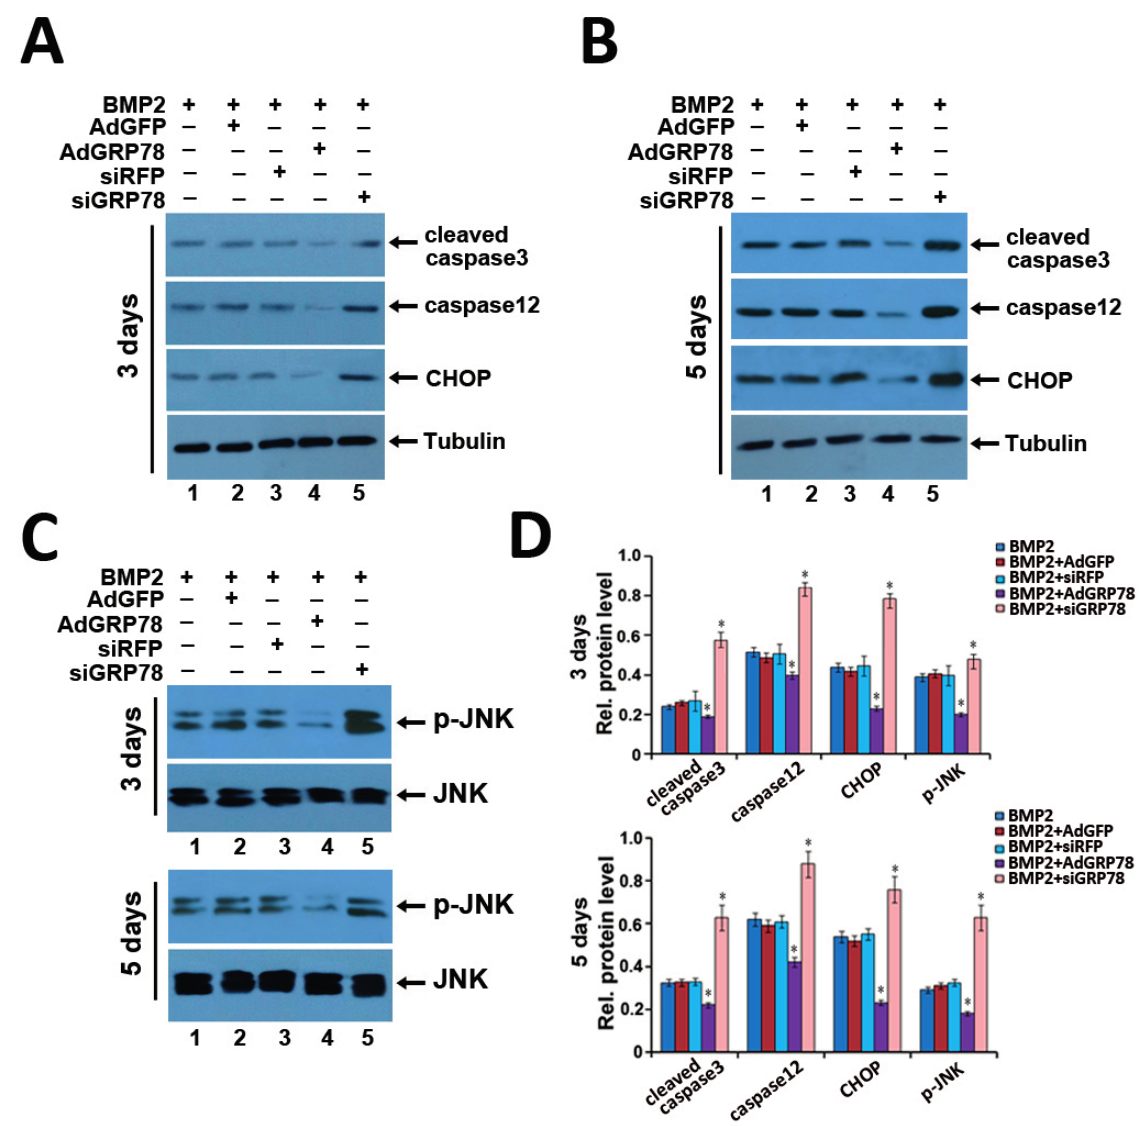
Figure 6. The effects of GRP78 on the expression of ER stress-associated molecules in BMP2-induced C3H10T1/2 cells for three and five days. ( A – C ) Expression of cleaved caspase3, CHOP, caspase12, tubulin, JNK and p-JNK in the course of chondrogenesis in a micromass culture of BMP2-induced C3H10T1/2 cells for three and five days. Whole cell lysates were prepared from C3H10T1/2 cells were treated with 300 ng/mL BMP2 for three and five days. The lysates were resolved by SDS-PAGE and then immunoblotted with antibodies against cleaved caspase3, caspase12, CHOP, JNK, p-JNK and Tubulin; ( D ) Semi-quantification of relative levels of cleaved caspase3, caspase12, CHOP and p-JNK. Levels were normalized against those of tubulin by MJ Opticon Monitor Analysis Software (Bio-Rad), data were expressed as means ± S.D. ( n = 3). * p < 0.05 as determined by Student’s t -test, versus BMP2 + Ad-siRFP and BMP2 + Ad-siGRP78 group, BMP2 + Ad-GFP and BMP2 + Ad-GRP78